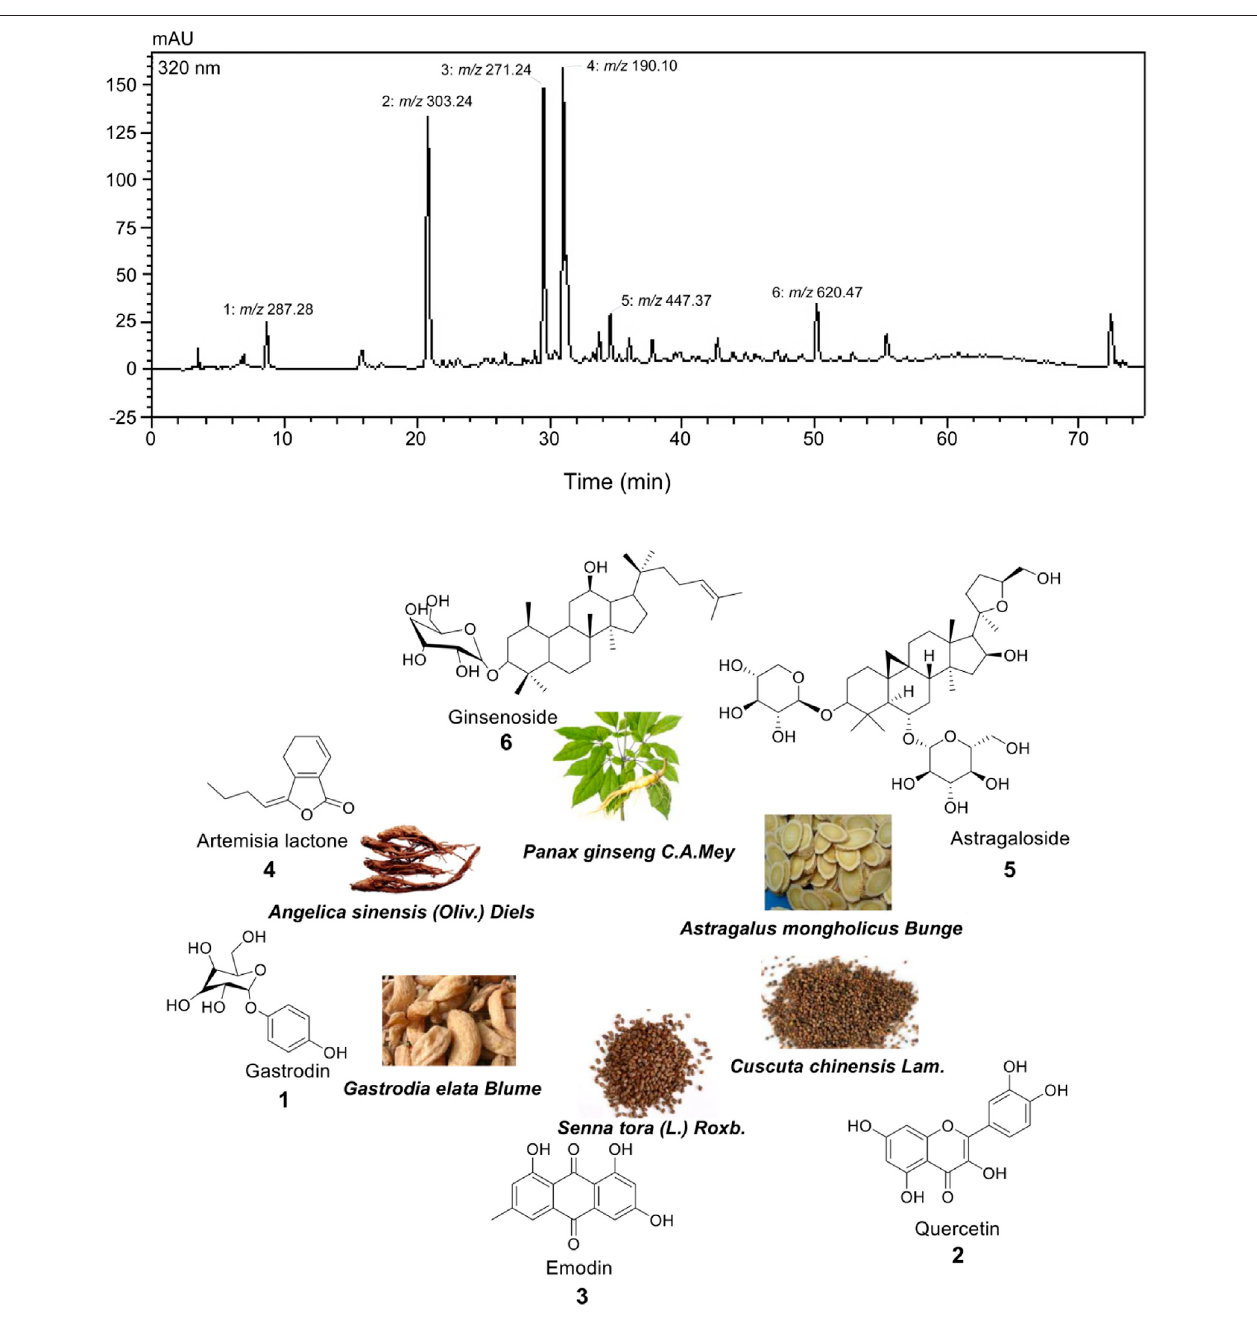
FIGURE 1 | Structures of compounds identi fi ed from Shiyiwei Shenqi Tablets.